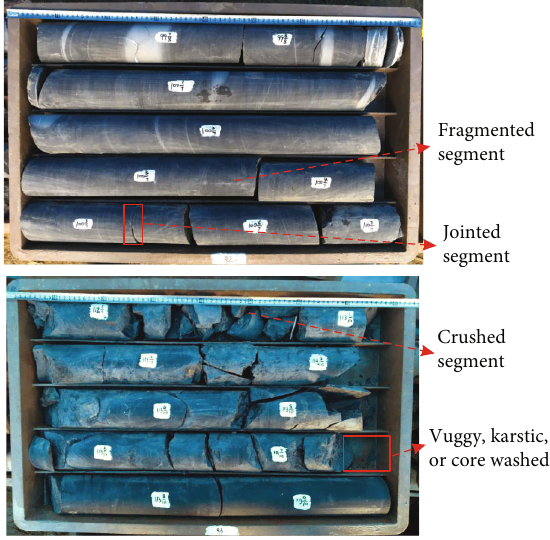
Figure 8: Presentation of di ff erent drilling